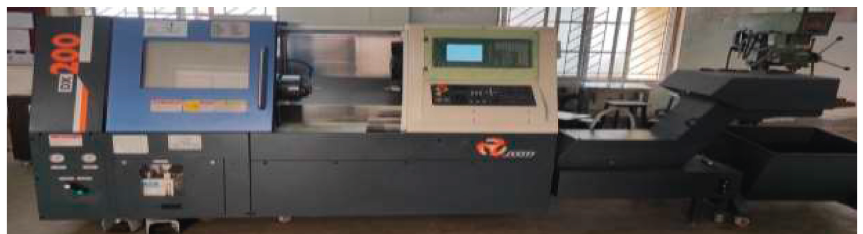
Figure 2: CNC turning machine.